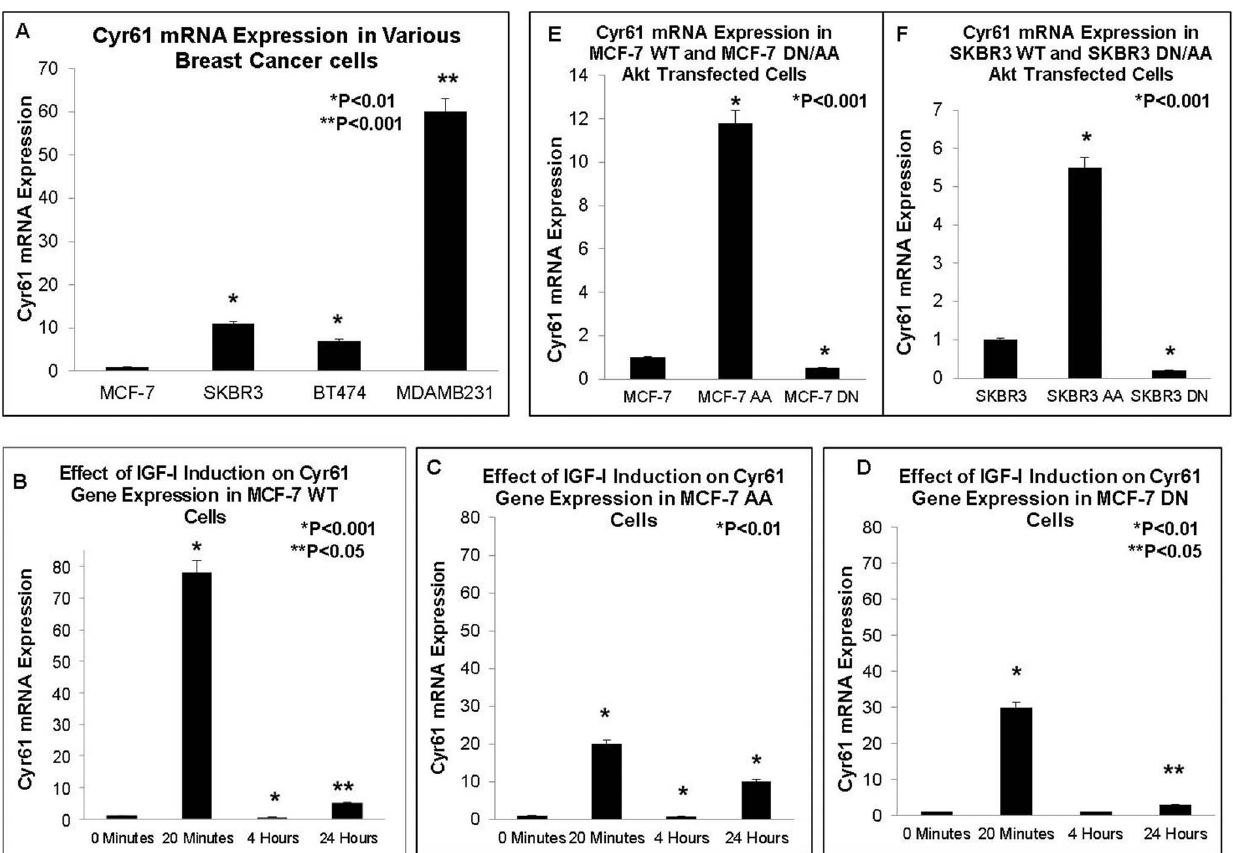
Figure 1. Cyr61 Levels in Various Breast Cancer Cell Lines – Baseline and in Response to IGF-1. ( A ) Baseline mRNA expression of Cyr61 in Wildtype MCF-7, SKBR3, BT474, and MDAMB231 as determined by RT-Q-PCR. ( B–D ) Cyr61 expression after IGF-1 treatment at baseline, 20 minutes, 4 hours, and 24 hours in ( B ) MCF-7 WT, ( C ) MCF-7 DN, and ( D ) MCF-7 AA cells. Cyr61 is increased by treatment of IGF-1, especially at 20 minutes. ( E ) Expression of Cyr61 mRNA in MCF-7 WT cells compared to MCF-7 AA (transfectant with constitutively active Akt), and MCF-7 DN (transfectant with dominant negative constitutively inactive Akt). ( F ) The results obtained in the MCF-7 cell line were confirmed by a second breast cancer cell line, SKBR3. All mRNA levels were adjusted for the housekeeping gene, 18S. P-values were calculated relative to MCF-7 WT in (A,E), to 0 Minutes in (B–D), and SKBR3 WT in (F). P , 0.05 is statistically significant.